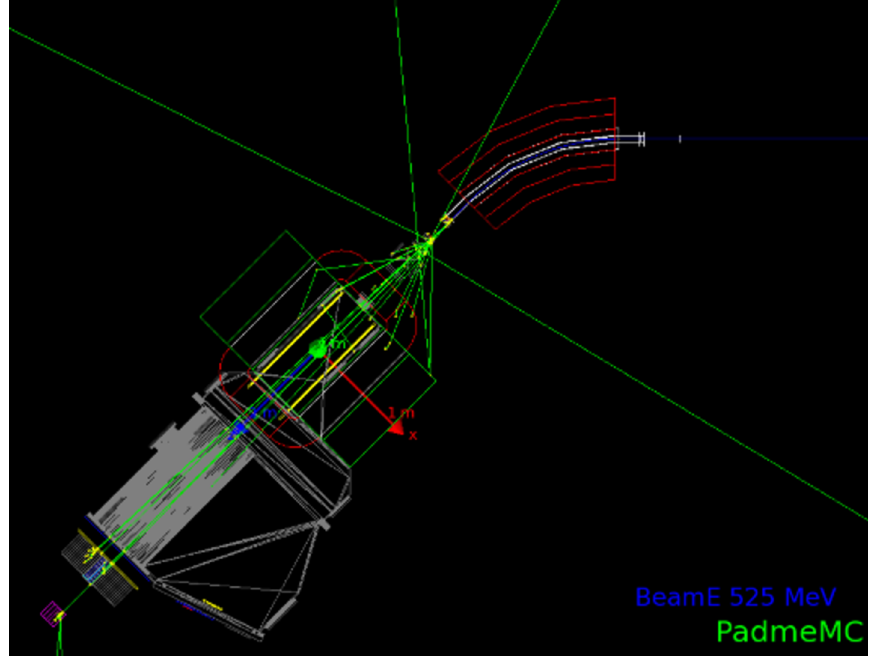
Figure 6 . Low-energy positron striking the DHSTB002 dipole exit flange, thereby generating a shower. Green lines represent